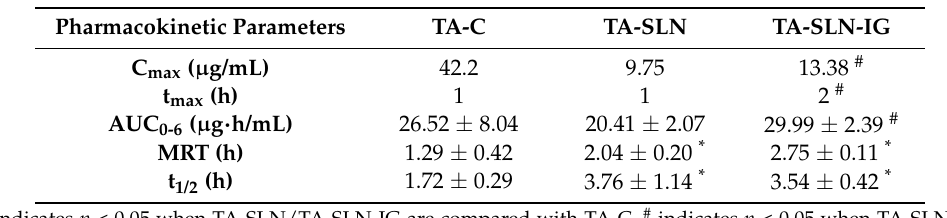
Table 5. Ocular tear pharmacokinetic parameters of triamcinolone acetonide at the end of 6 h after the topical administration of TA-SLN (F5), TA-SLN-IG (F13), and TA-C in New Zealand albino rabbits (mean ± SD, n = 3).